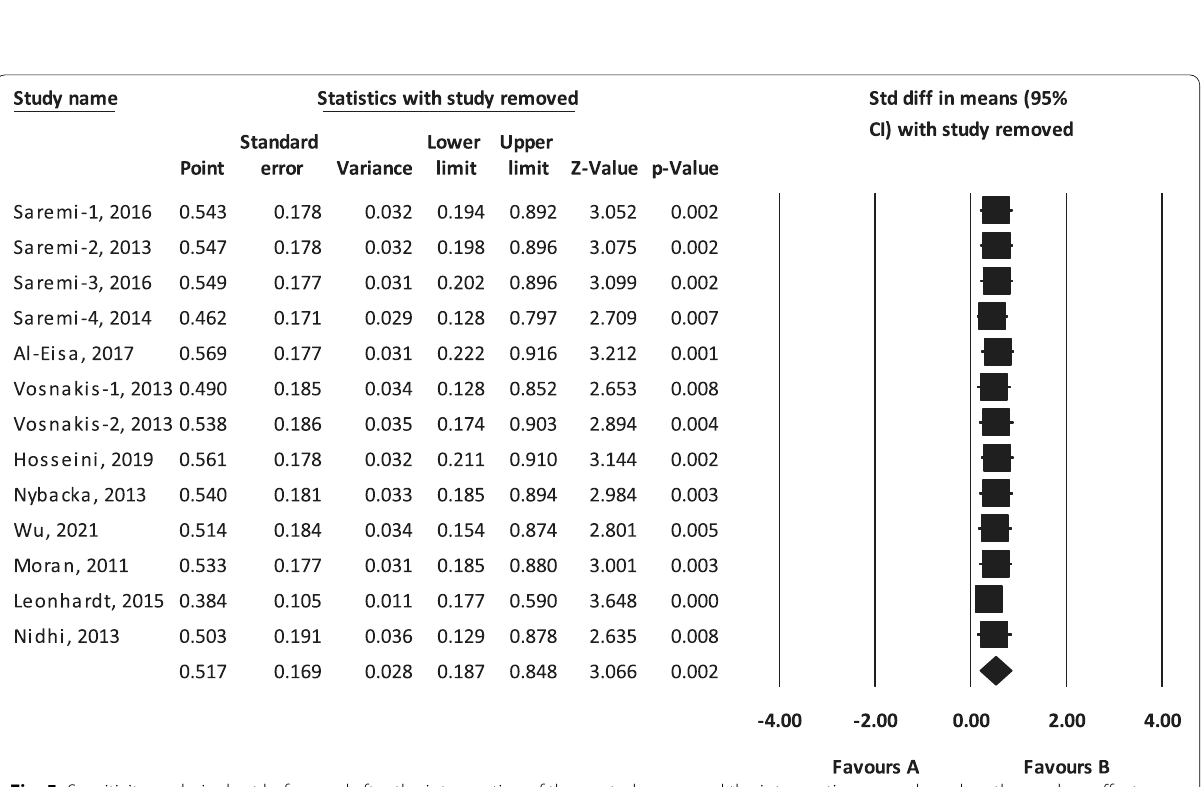
Fig. 5 Sensitivity analysis chart before and after the intervention of the control group and the intervention group based on the random effects